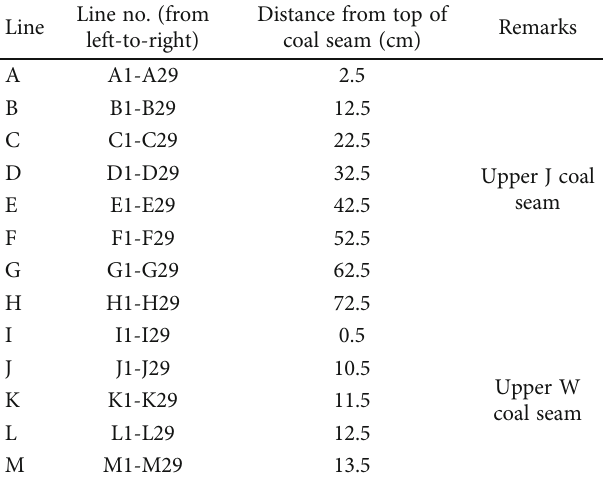
Table 2: Survey line layout